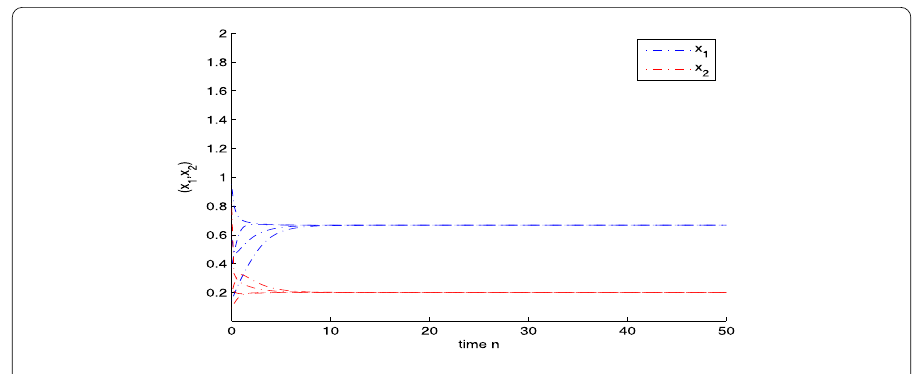
Figure 2 Numeric simulations of system (4.1) with initial conditions ( x (0), y (0)) = (0.14,0.19),(0.37,0.009),(0.95,0.024), and